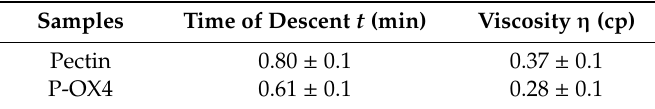
Table 3. Results of viscosity measurements ( n = 3; ±